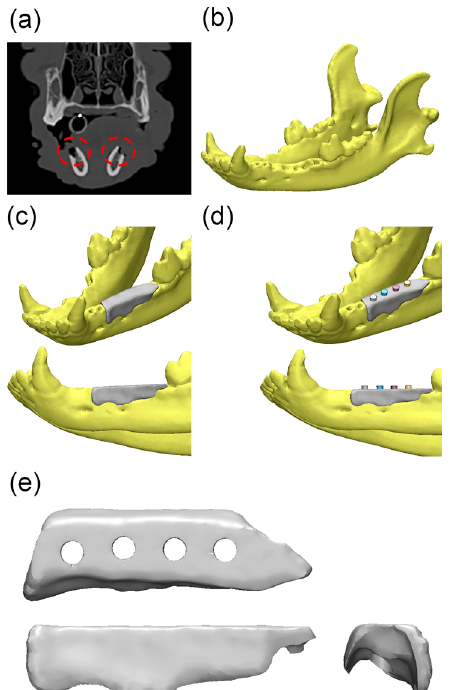
Figure 12. Overall modeling process of the implant guide scaffold: (a ) Red dashed line: alveolar bone defect of mandible; (b ) 3D modeling process of CT image; ( c ) 3D scaffold cover of the defect area; ( d ) 4 thru holes for inserting implant fixture; ( e ) Final model of implant guided scaffold.